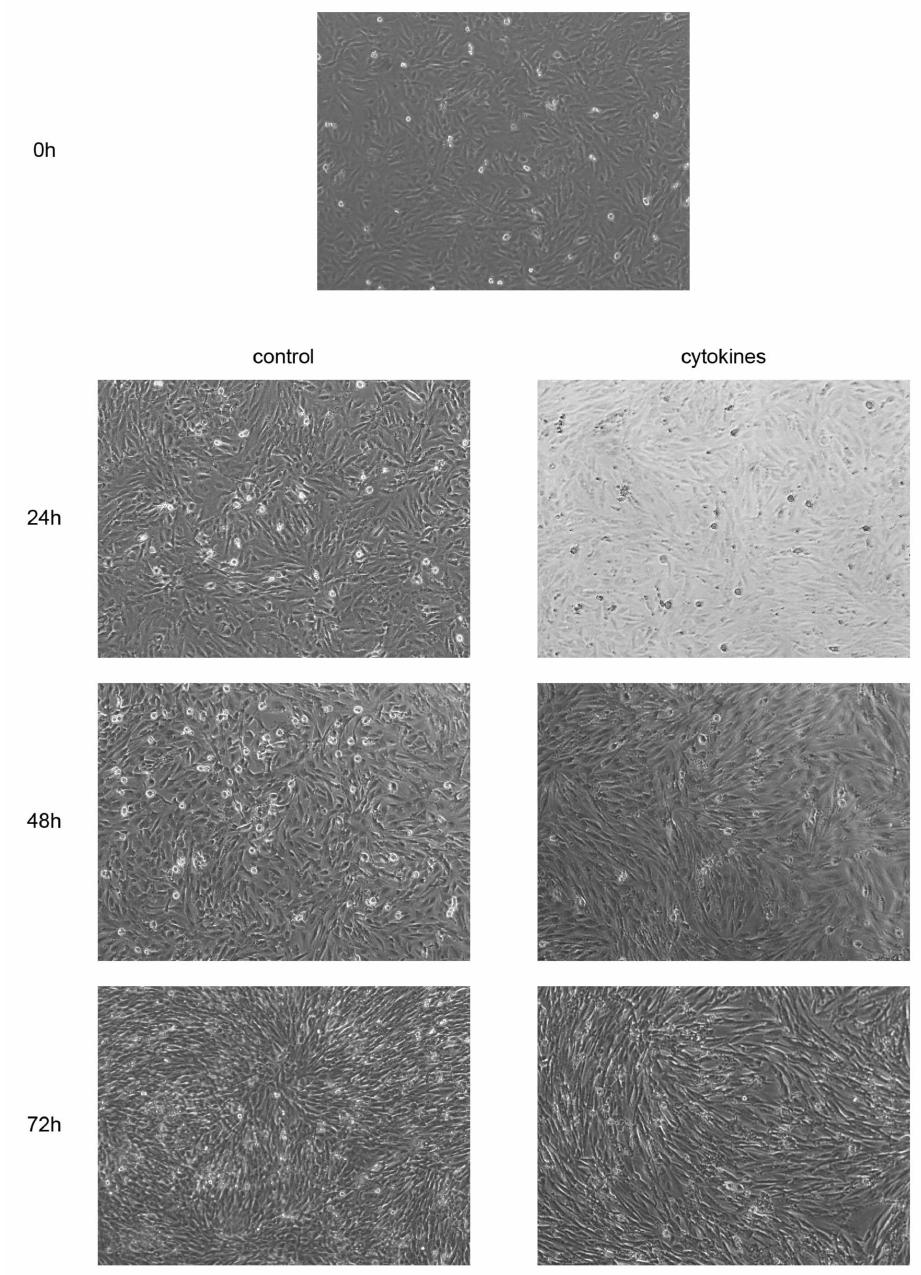
Figure 6. Effects of pro-inflammatory cytokines on cell morphology. EM-E6/E7/TERT cells were cultured with or without TNF α (500 ng/mL) and IL-1 β (100 ng/mL) for 72 h. Original magnification ×